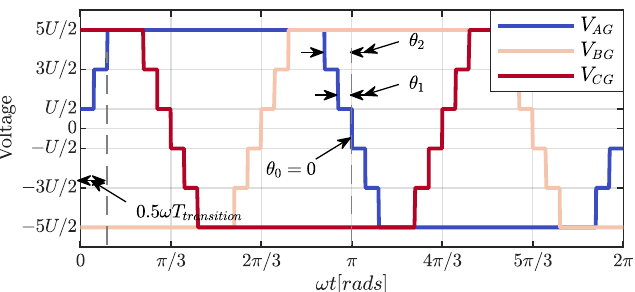
Figure 2. Phase-to-ground voltage waveforms of a 3 φ multilevel DAB